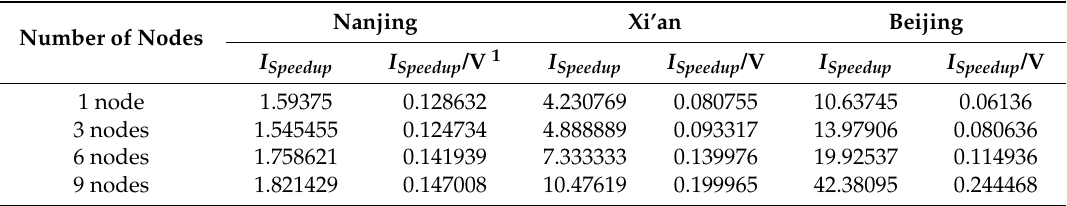
Table 5. Comparison of the speedup between different numbers of nodes. Nanjing Xi’an Beijing Number of Nodes I Speedup I Speedup /V